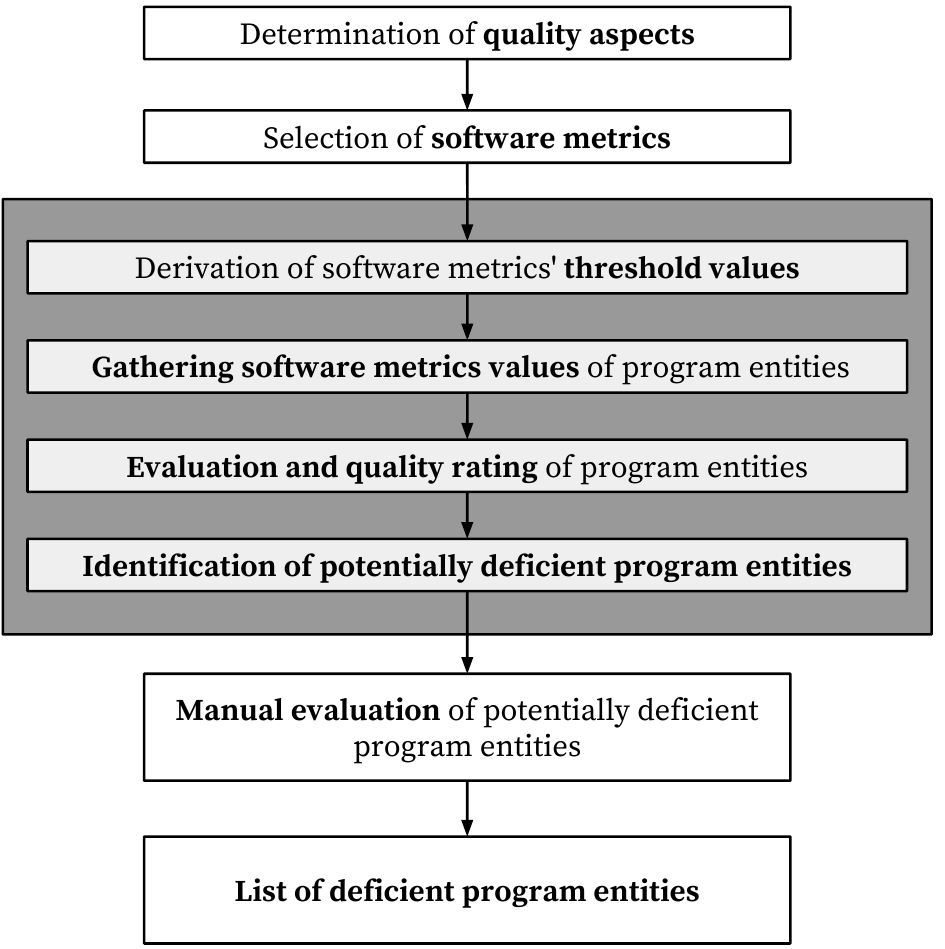
Figure 1. Identification of deficient program entities including steps of the proposed identification